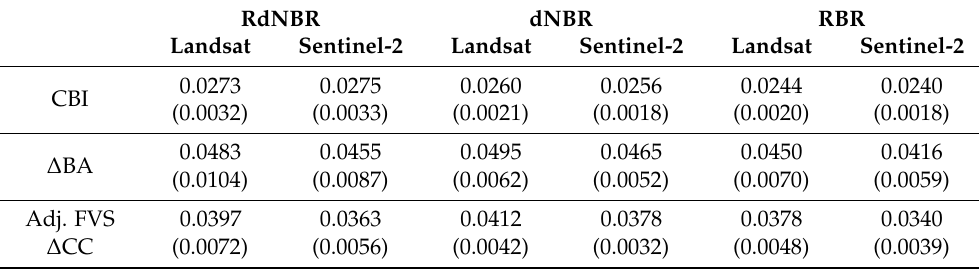
Table A6. Test MSE (and standard deviation of test MSE in parentheses) averaged across 7-fold CV of single-predictor GAM models for the EA time series.